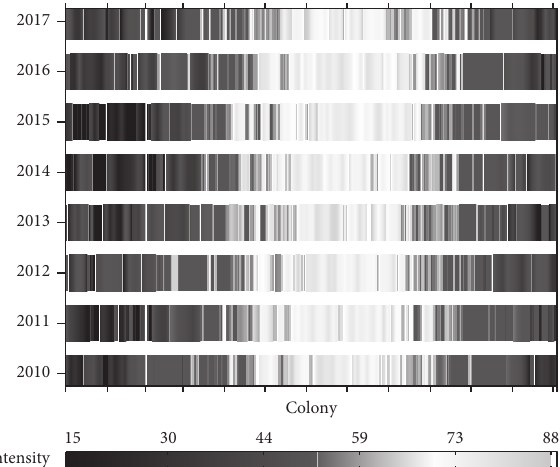
Figure 4: Clustering diagrams on the two